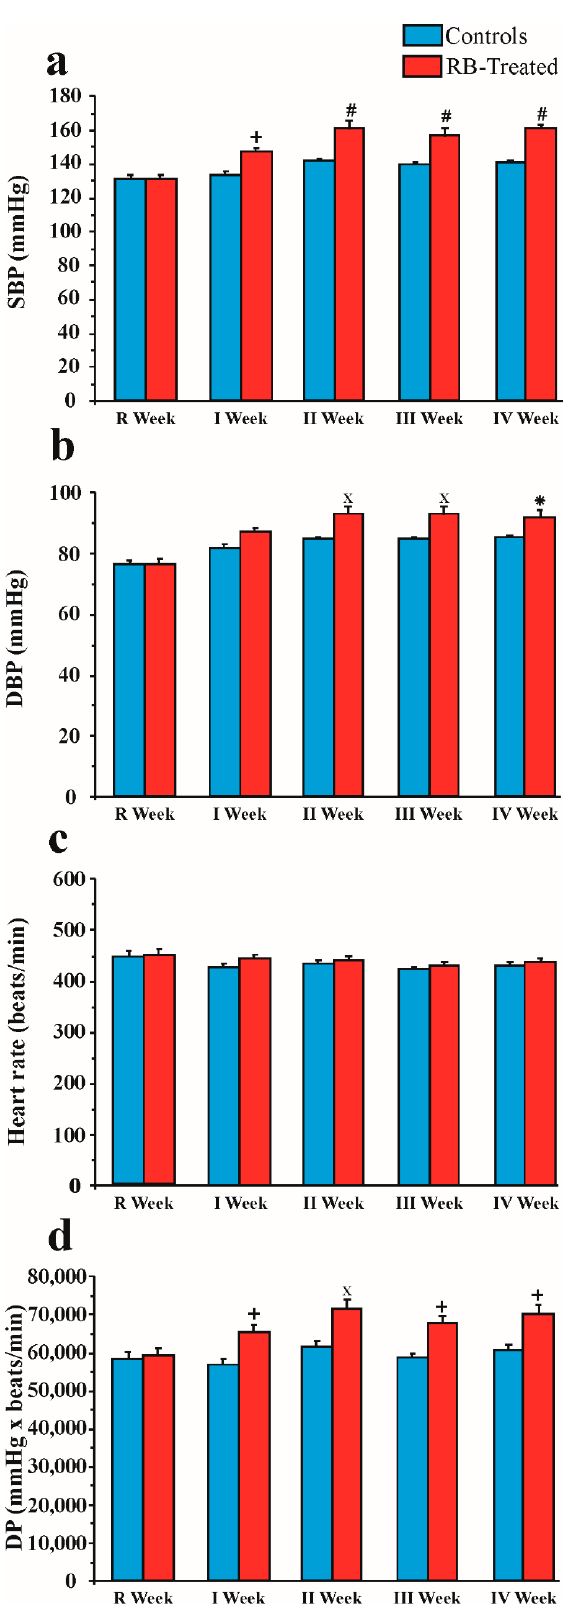
Figure 3. Cardiovascular hemodynamic parameters in RB-treated and control rats during the 4 weeks of treatment. ( a ) SBP, systolic blood pressure; ( b ) DBP, diastolic blood pressure; ( c ) heart rate; ( d ) DP, double product. Values are expressed as the mean ± SEM; RB-treated vs. controls: * p < 0.05, + p < 0.005, × p < 0.001, # p < 0.0001. Statistical analysis: two-way